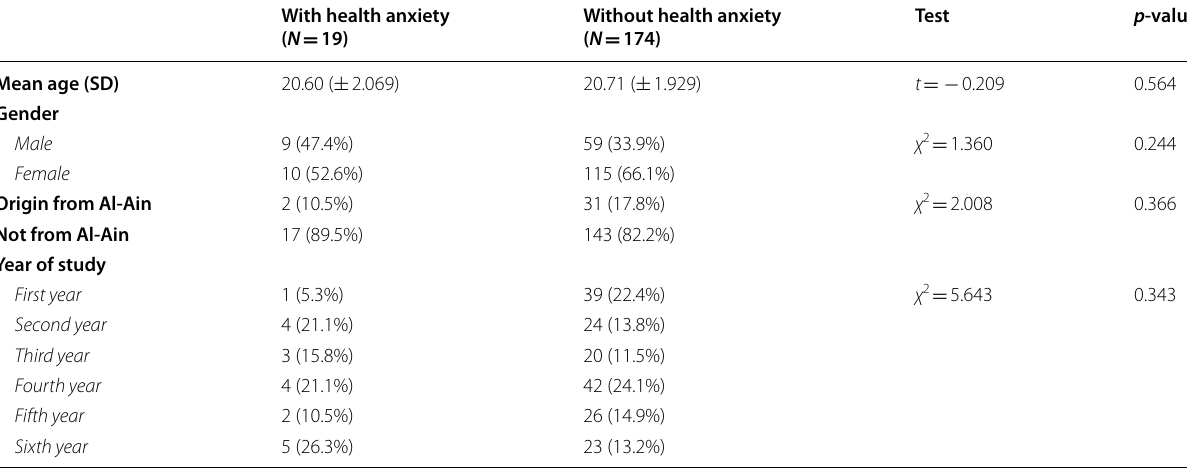
N , Number, SD Standard deviation, t Student t -test, χ 2 chi-square test